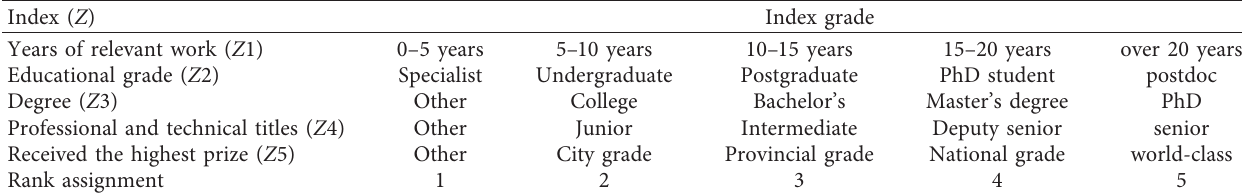
Table 1: Expert evaluation index